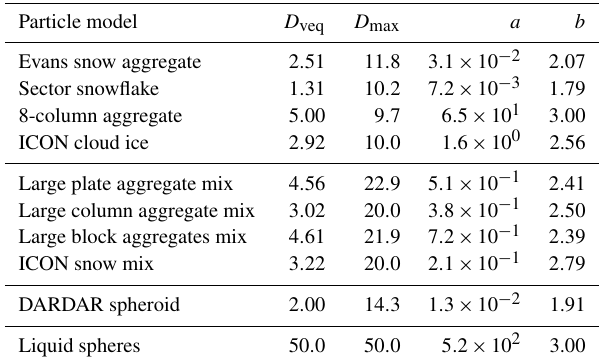
Table 1. Summary of the particle models used. Given sizes are in millimetres and refer to the largest particle size of each model. Fur- ther details are found in the